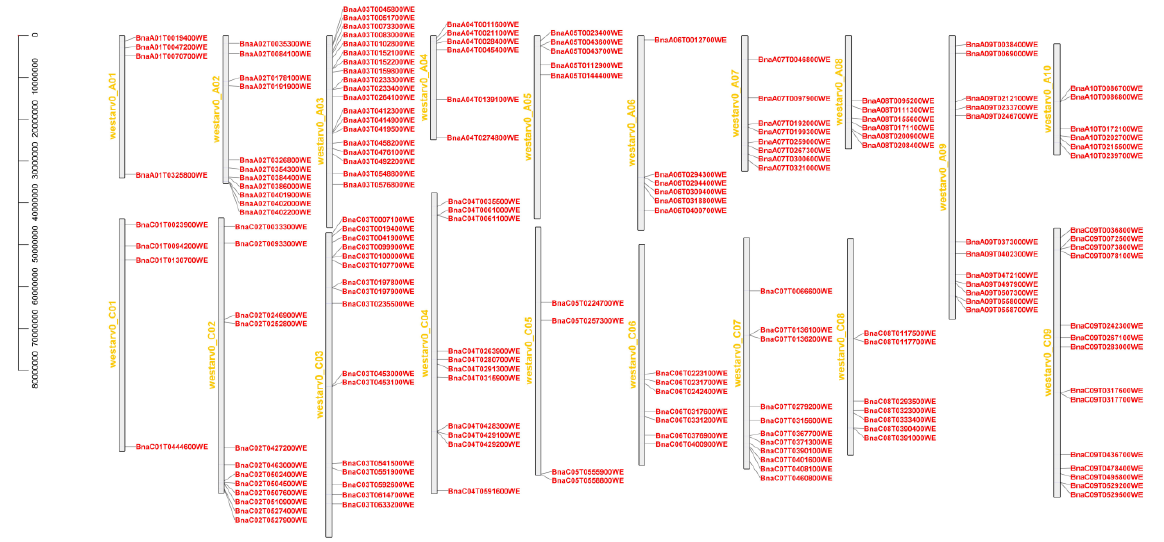
Figure 2. Chromosomal distribution of B. napus BnaMIKC genes. The scale represents base pairs (bps). The chromosome numbers are shown on the left side of each vertical bar.